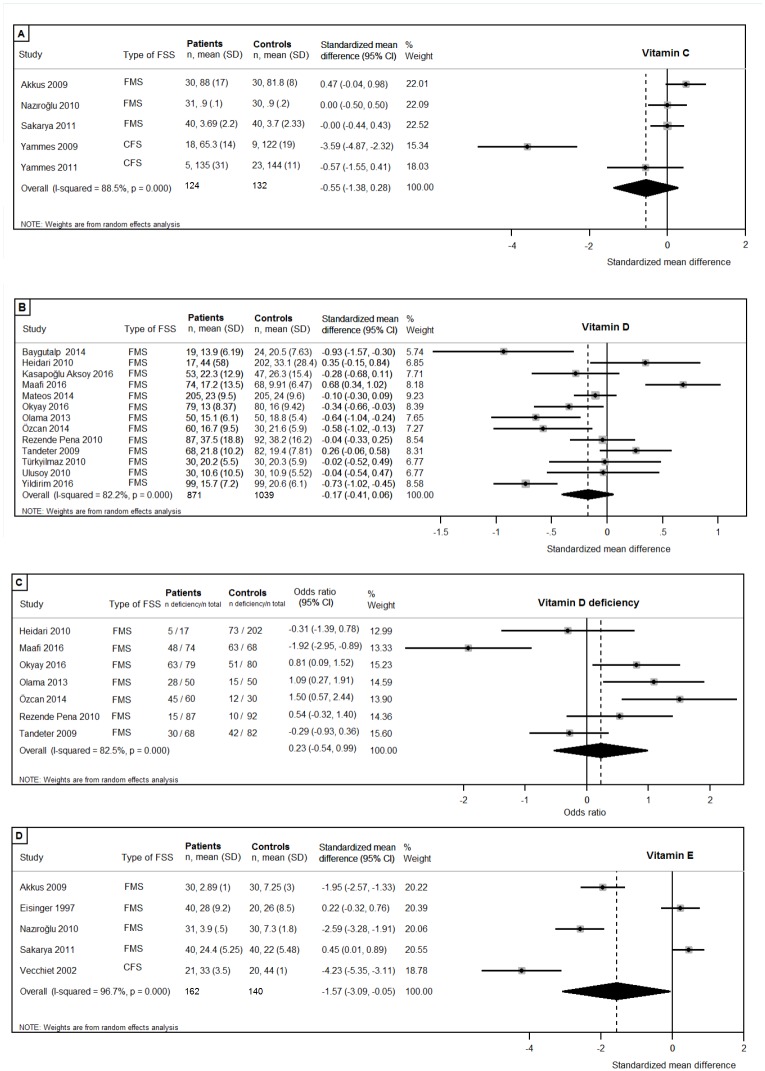
Forest plots of studies investigating vitamins.(A) Vitamin C; (B) Vitamin D; (C) Vitamin D deficiency (<20ng/ml); (D) Vitamin E.